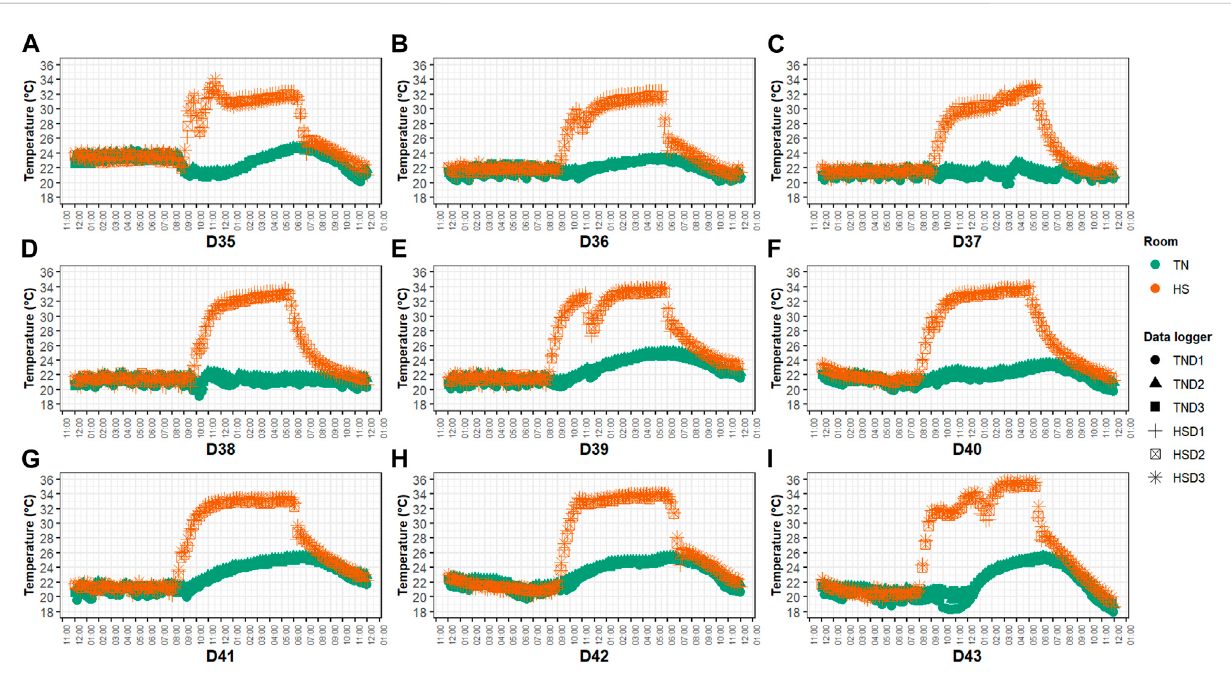
FIGURE 2 Hourly temperature (A – I) of the two rooms during the cyclic HS period. Note: D#, day#; TN, thermoneutral conditions; HS, (cyclic) heat stress conditions; TND#, data logger# in room TN; HSD#, data logger# in room